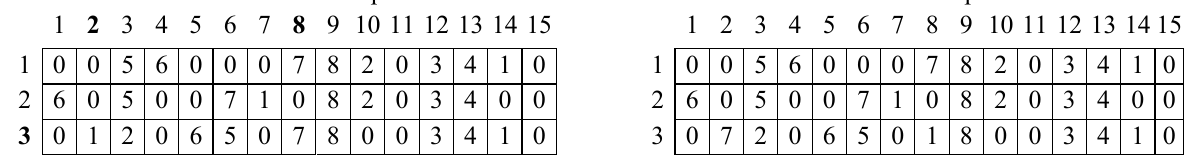
Fig. 5. Swap operation illustration for random period-3 with random numbers i = 8 and j = 2 Reversion operation